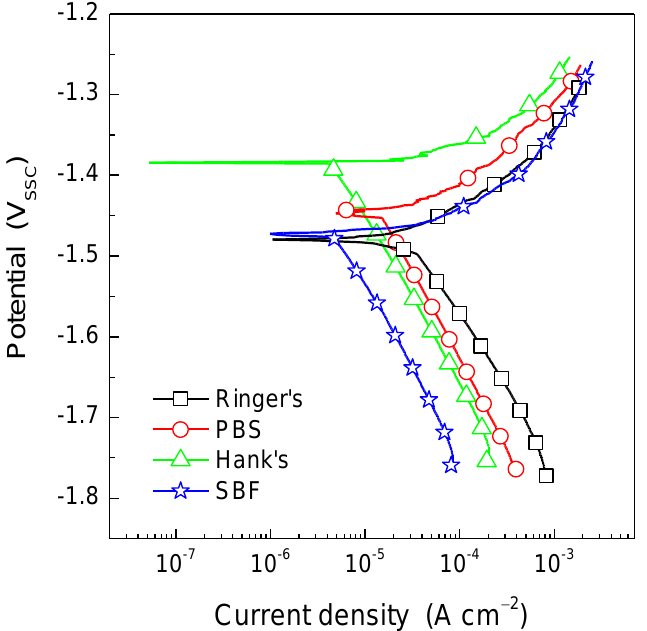
Figure 5. Potentiodynamic polarization curves for the AZ31B Mg alloy specimens in Ringer’s, PBS, Hank’s, and SBF solutions at 37 ◦ C. Scan rate was 1 mV/s. Typical data from replicated experiments are presented.